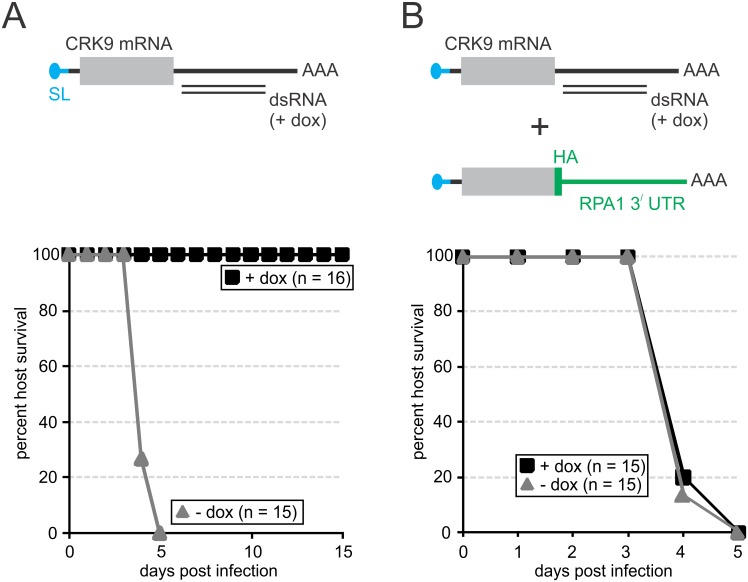
Validation of CRK9 as a drug target in the mouse.(A and B, top) Depiction of CRK9 mRNAs and the targeting dsRNA in two cell lines derived from the T. brucei brucei 427 smBF cell line which were used for mouse infection studies. The cell line on the left (A) harbored a construct for conditional expression of dsRNA that targets the 3/ UTR of the CRK9 mRNA. This line was further modified (B) by targeted integration of a plasmid into the endogenous CRK9 locus that fused a functional HA tag sequence and the 3/ UTR of RPA1 to the 3/ end of one CRK9 allele, making the corresponding mRNA resistant to the RNAi response. As the survival graphs of infected mice show in the bottom panels, doxycycline treatment rescued every single mouse when CRK9 was depleted. This effect was completely abolished upon introduction of an RNAi-resistant CRK9 gene into the same trypanosomes.